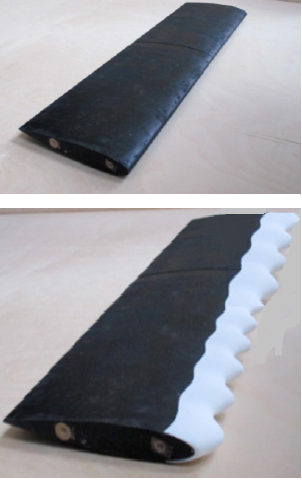
Figure 1. Overview of the experimental blades, the normal blade (up) and wavy blade